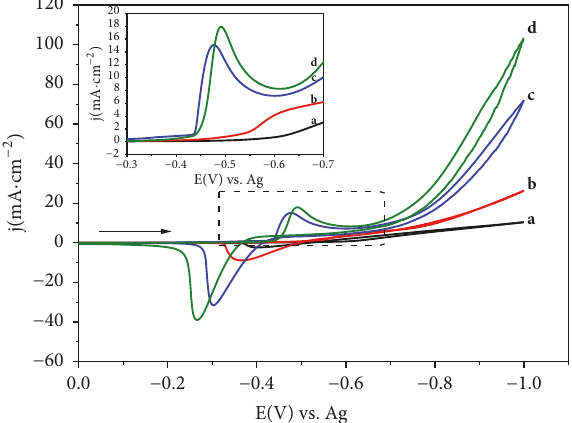
Figure 2: Cyclic voltammograms of 40mM SnO in [Bmim]HSO 4 on GC electrode with different water content and local enlarged image: (a) 0% H 2 O, (b) 10% H 2 O, (c) 30% H 2 O, and (d) 50% H 2 O. Scan rate: 50mV/s,